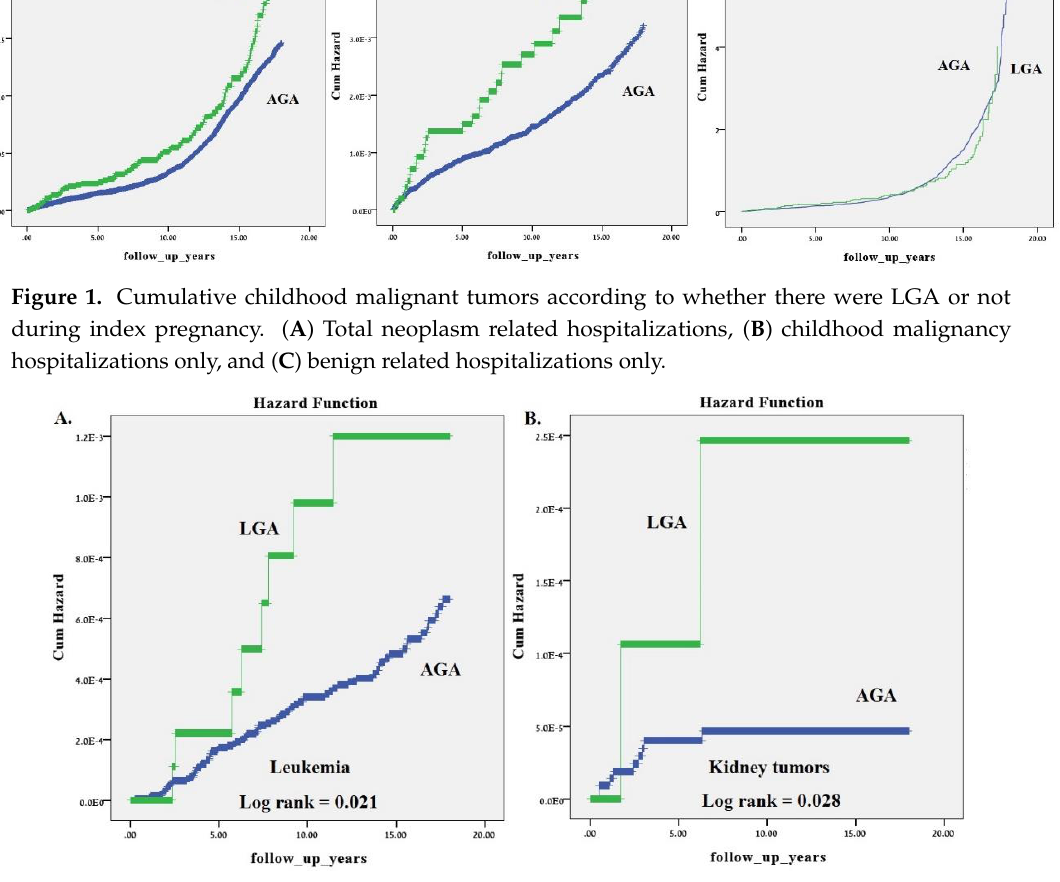
Figure 2. Cumulative childhood related hospitalizations due to malignant tumors according to whether there were LGA or not and the type of tumor. ( A ) Leukemia and ( B ) kidney tumors.